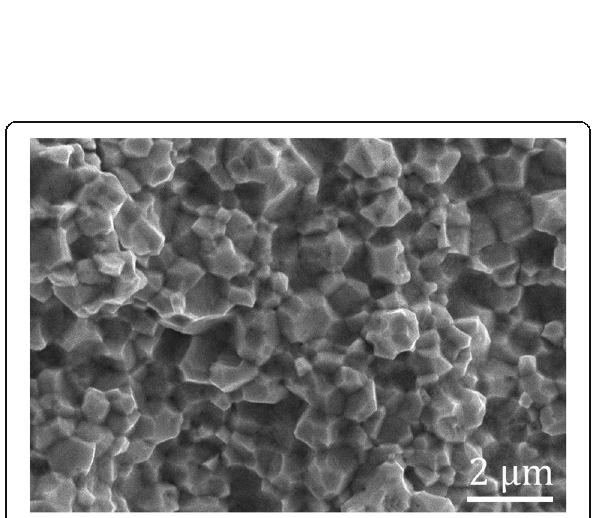
Fig. 9 The microstructure of the W